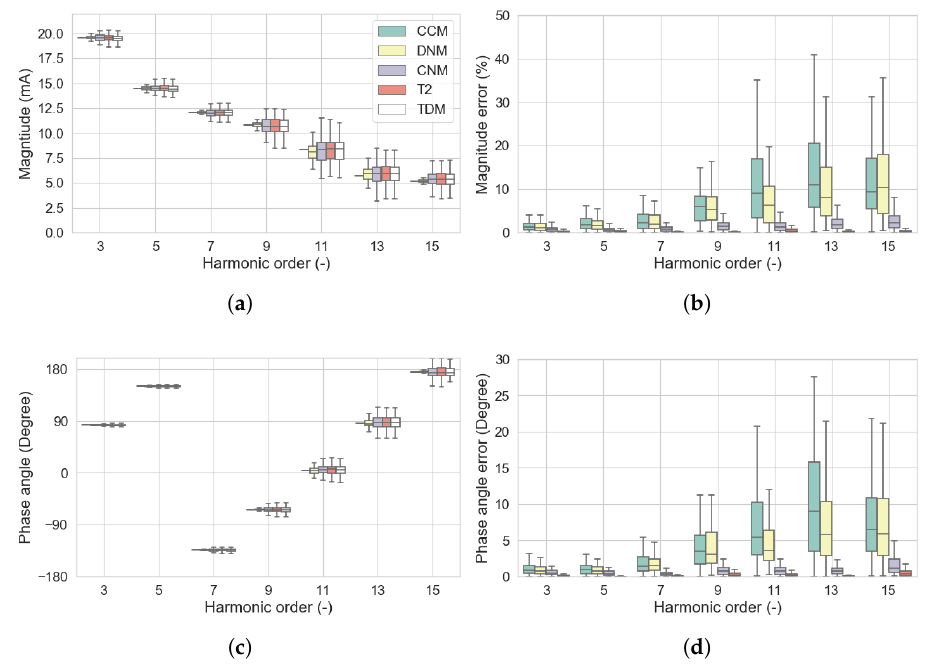
Figure 9. Comparison of the Type A LED lamp frequency domain models for flat-top voltage supply: ( a ) Magnitude; ( b ) Magnitude error; ( c ) Phase angle; and ( d ) Phase angle